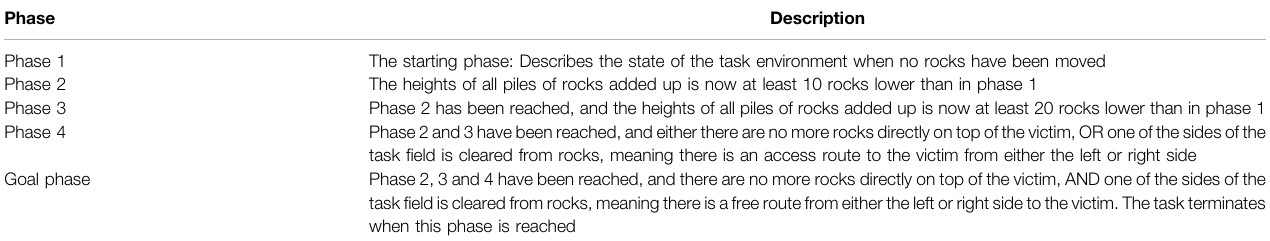
TABLE 2 | The task conditions speci fi ed for each Phase Variable used in the state space of the Reinforcement Learning algorithm. Phase Description Phase